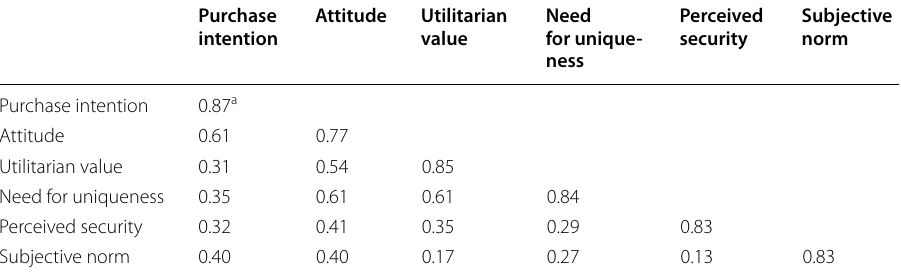
Correlation coefficients are estimates from Amos 22. All correlations are significant at p < 0.001 a Diagonal elements are square roots for the